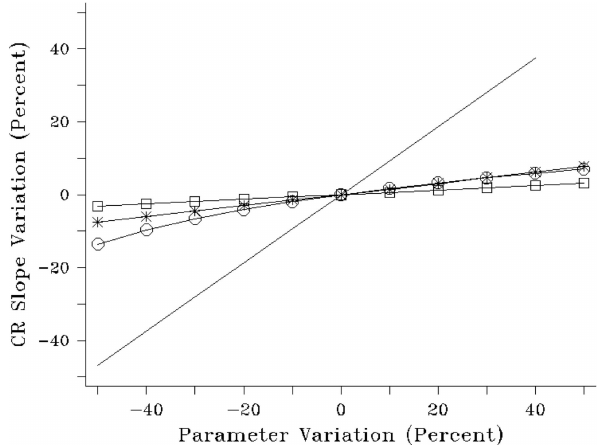
Figure 4. Parameter sensitivity of the complementary relationship slope. Results shown are for varying the slope of the saturation- specific humidity with respect to temperature (no symbols), surface drag coefficient (circles), surface cloud radiative forcing (stars), and convective adjustment timescale